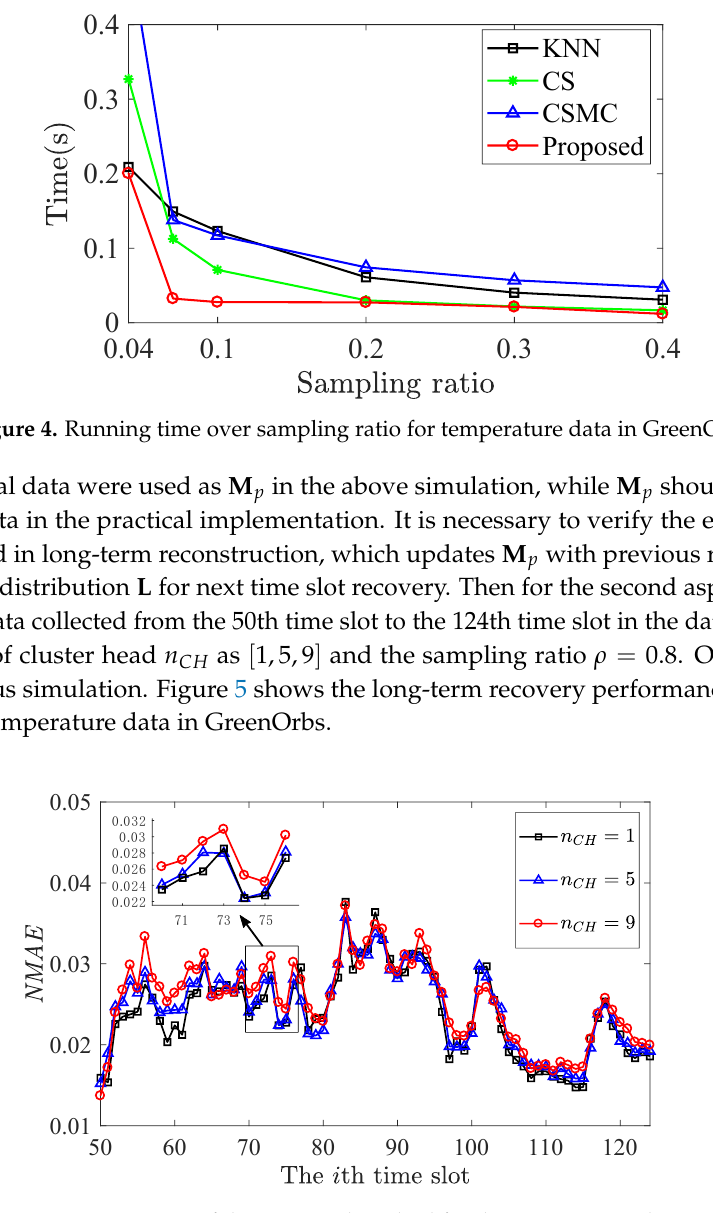
Figure 5. Long-term recovery of the proposed method for the temperature data in